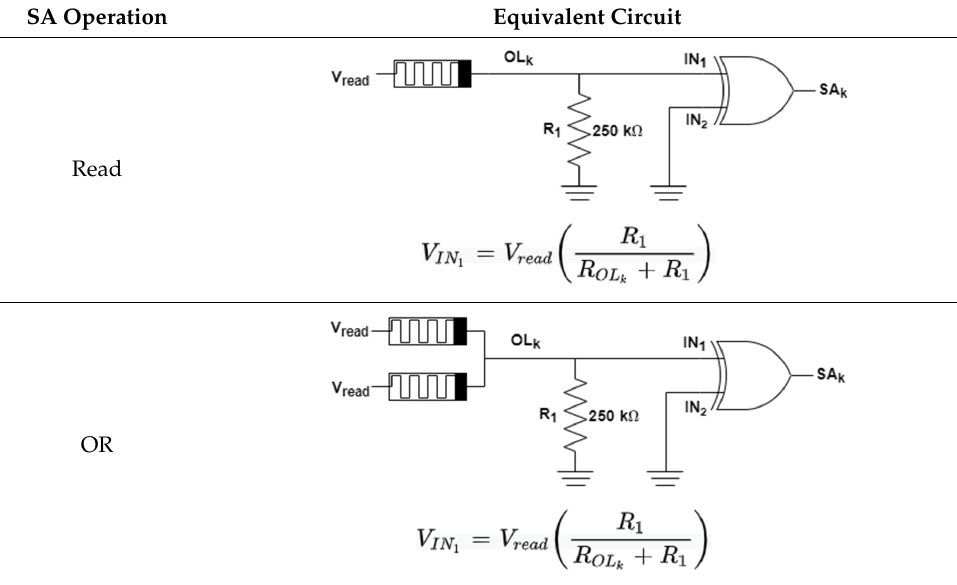
Table A1. Equivalent circuits for all possible configurations of the sensing module.